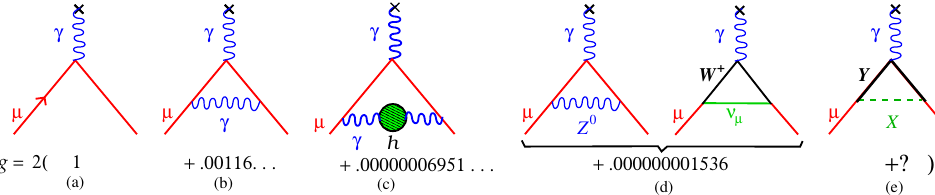
Figure 3: Radiative contributions to the muon anomaly from QED, the strong and the electroweak forces, showing their relative strengths. The Higgs boson does not contribute in the lowest order, but is important in the second-order electroweak con- tribution. (e) shows a possible contribution from as yet undiscovered new physics beyond the Standard